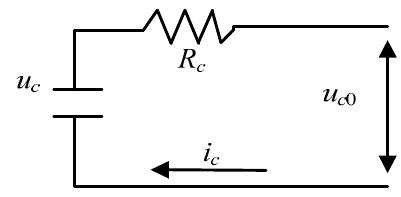
Figure 7. Equivalent-circuit model of a single ultracapacitor [19].